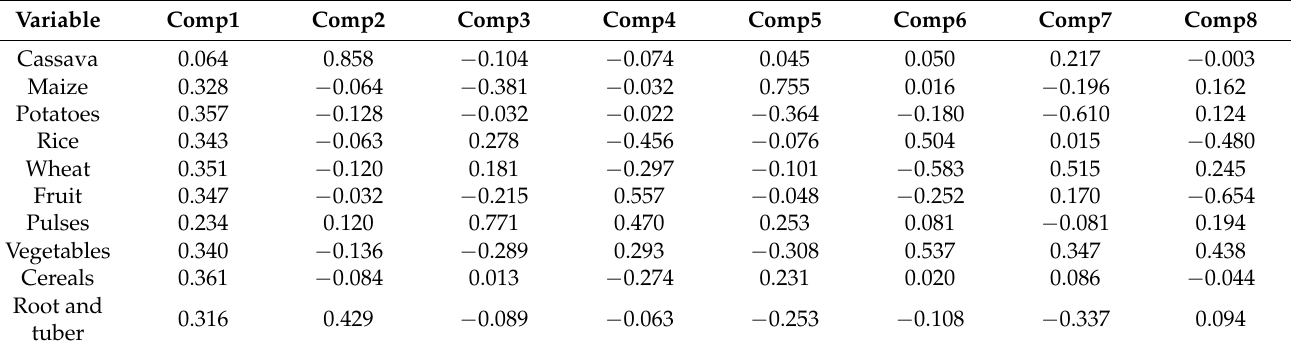
Table A4. Principal components